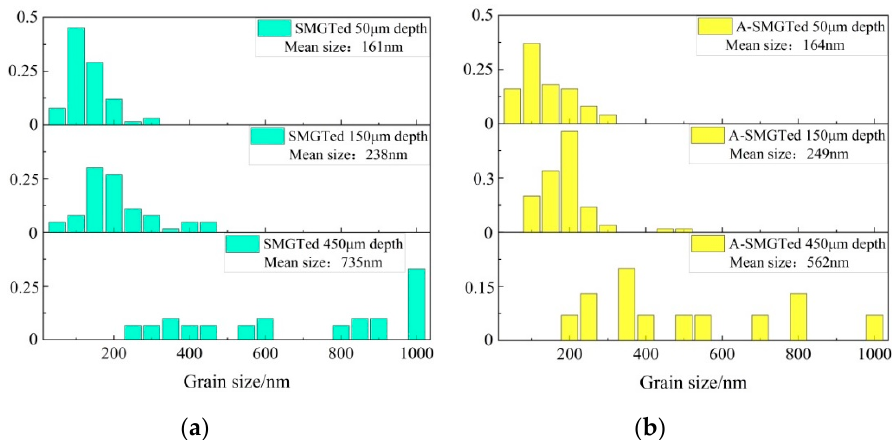
Figure 4. Statistical grain size of ( a ) SMGTed sample. ( b ) A-SMGTed sample. (For Figure 3e,f, grain size is taken as size of dislocation cells, as arrow indicates).